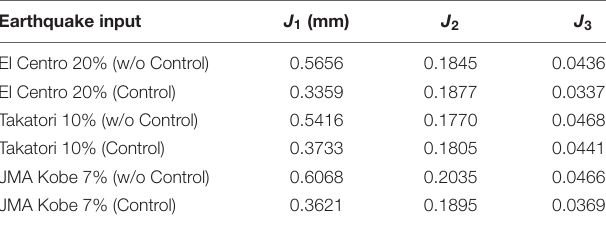
TABLE 4 | Error indications of RTHS performance under different earthquake